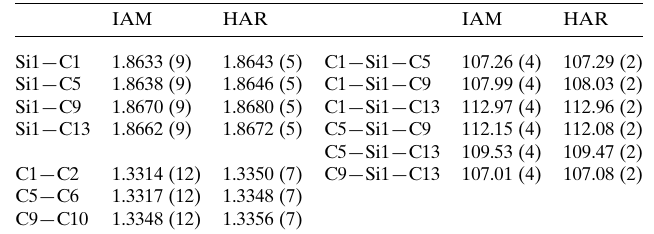
Table 2 Selected geometric parameters of compound 2 (A˚ , (cid:3)